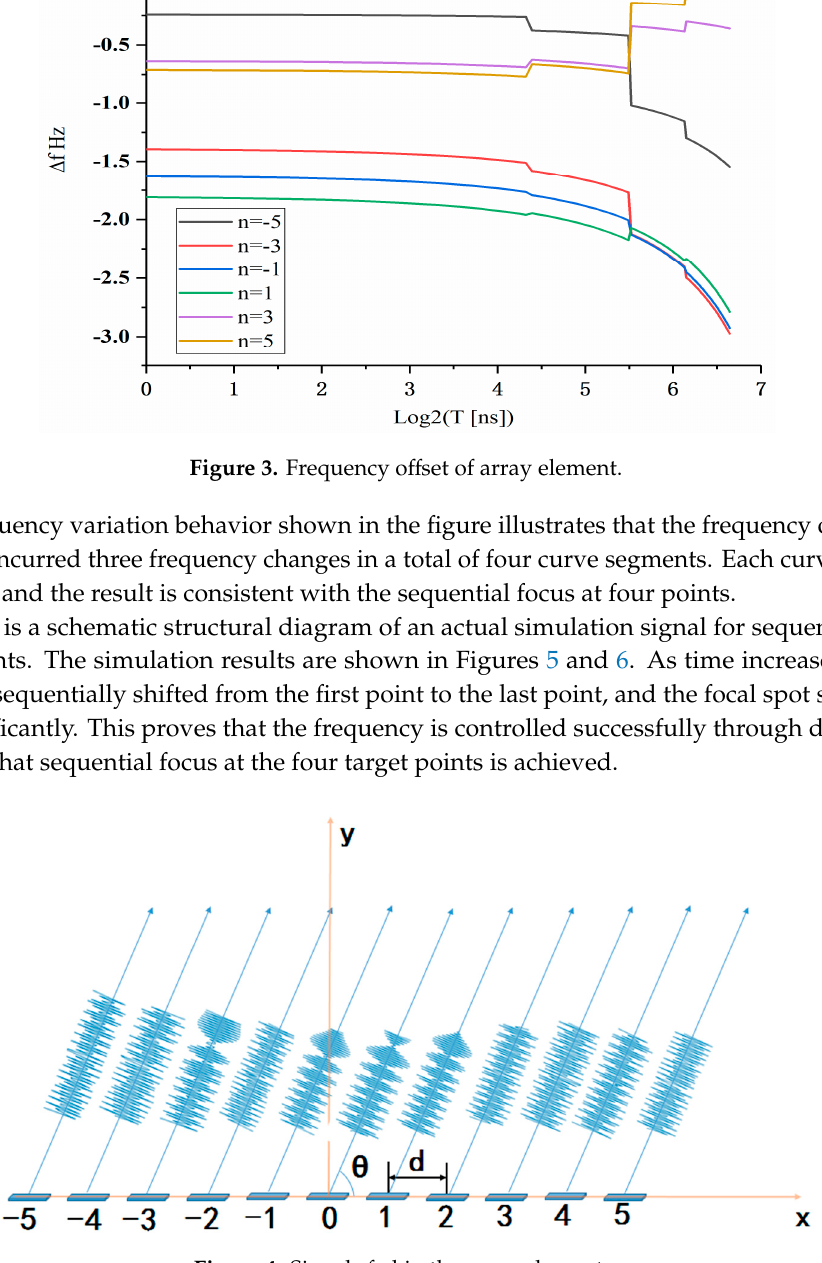
Figure 4. Signals fed in the array elements.